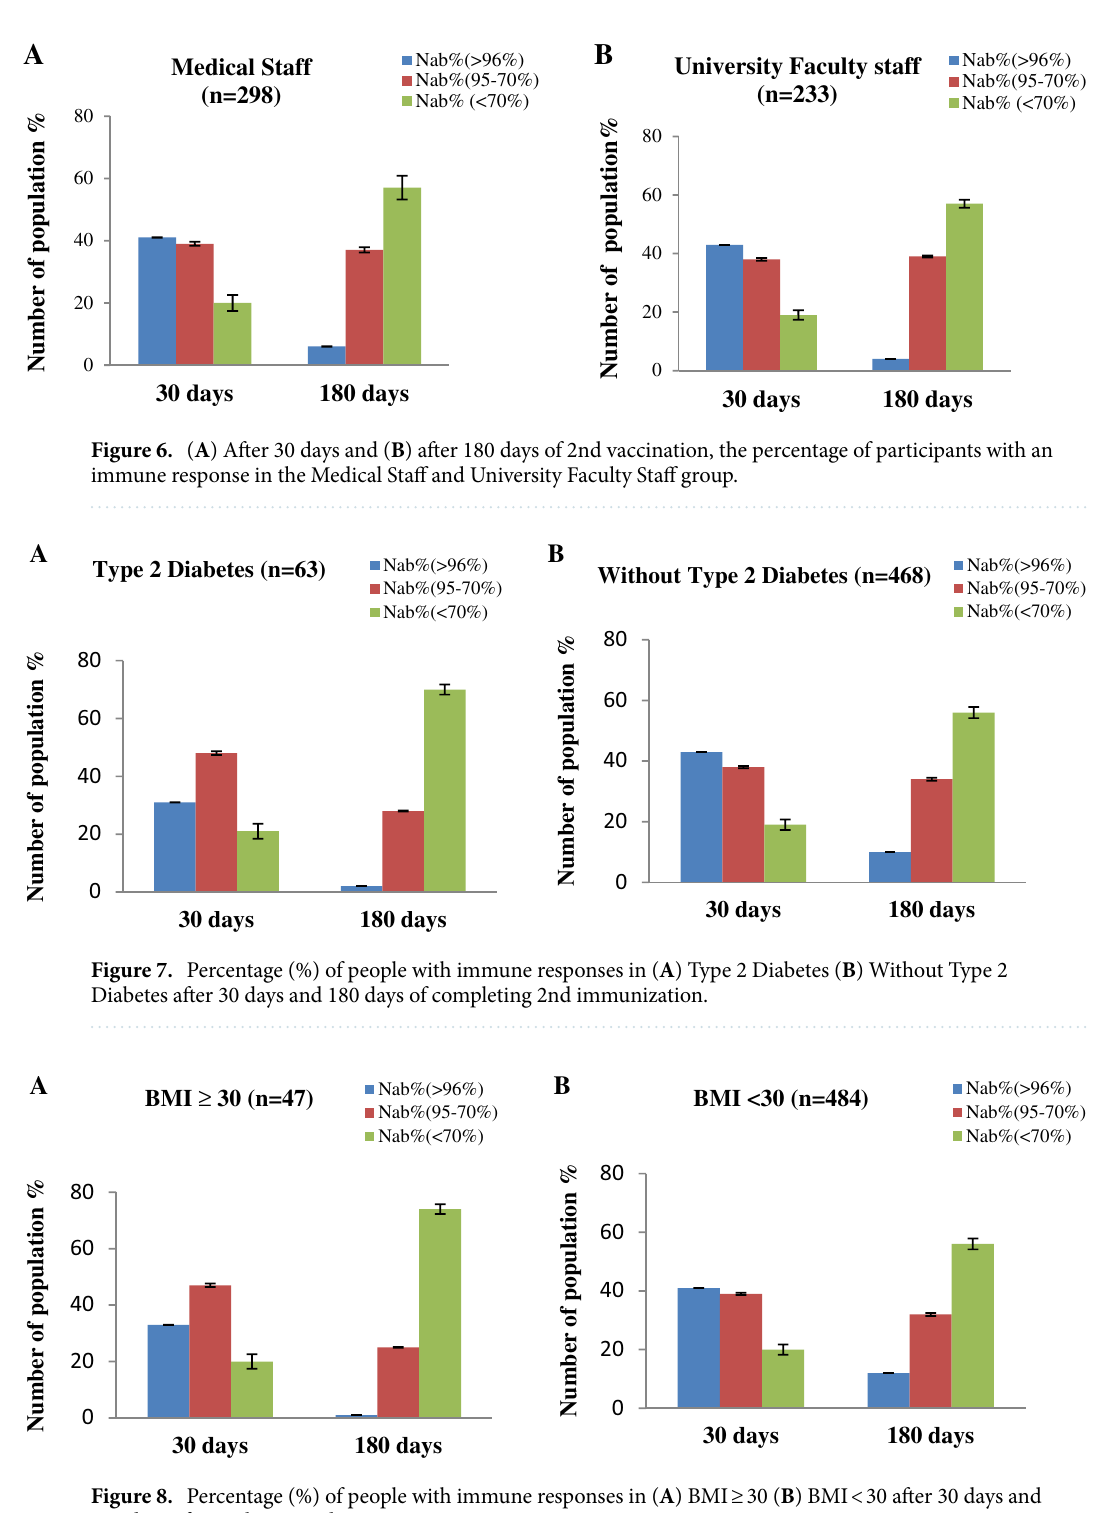
Figure 8. Percentage (%) of people with immune responses in ( A ) BMI ≥ 30 ( B ) BMI < 30 after 30 days and 180 days of completing 2nd